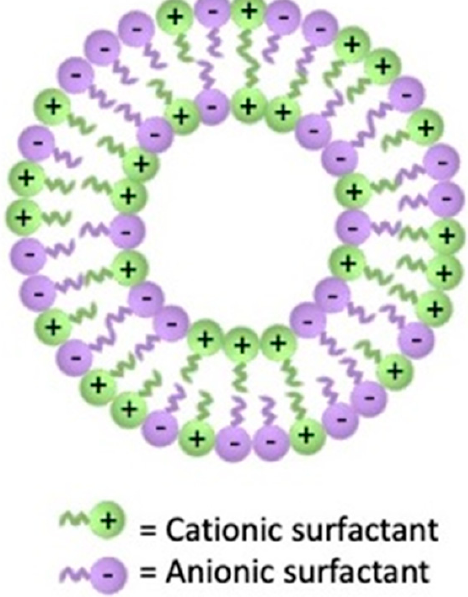
Figure 8. Schematic structure of catanionic vesicles.